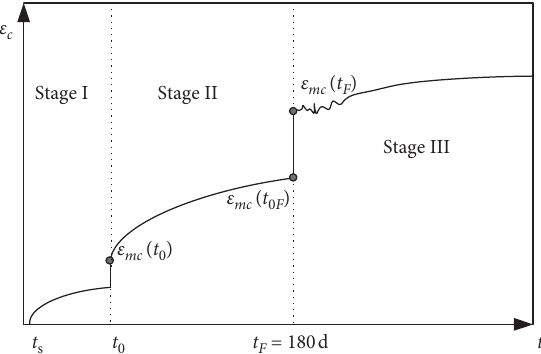
Figure 5: Strain variations of the measuring point in the creep tests. Table 3: Values of ε mc , A and ε mc , B for each specimen (unit: με ). ε Beam number